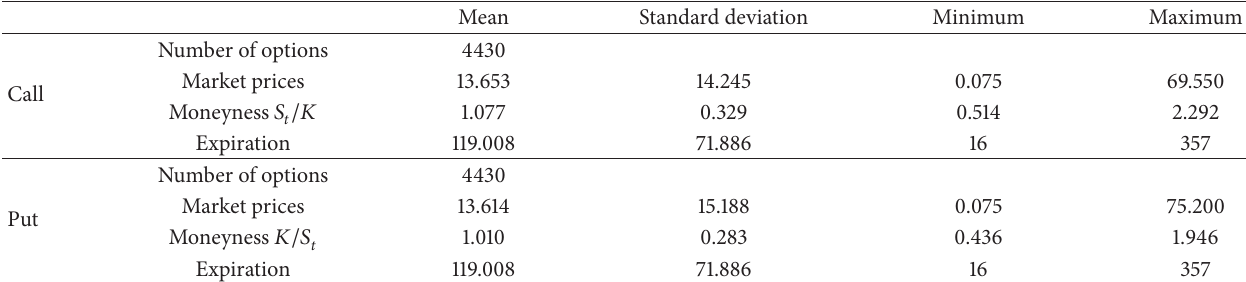
Table 4: Data description of IBM calls and